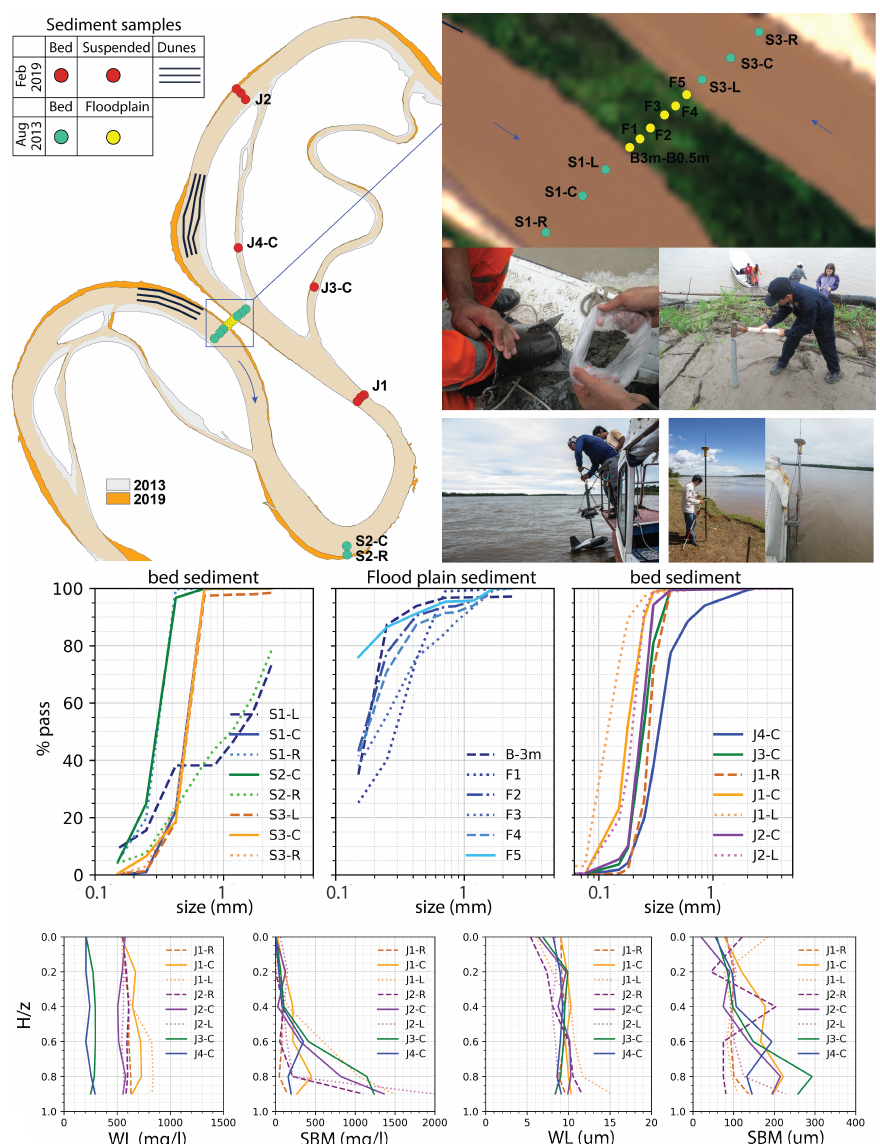
Figure 9. Sediment characterization (location, sediment size distribution and suspended sediment concentration) along the JH bend (main channel (S1-R, S1-C, S1-L, S2-C, S2-R, S3-L, S3-C, and S3-R) and floodplain (B-3m, F1, F2, F3, F4 and F5) samples were collected in August 2013, while secondary channel (J1-L, J1-C, J1-R, J2-L, J2-C, J3-C and J4-C) samples were collected in February 2019). Pictures show the collection of suspended and floodplain sediments. WL: wash load; SBM: suspended bed material. Along the upper and lower reaches, three 3-km longitudinal profiles for bedform characterization were